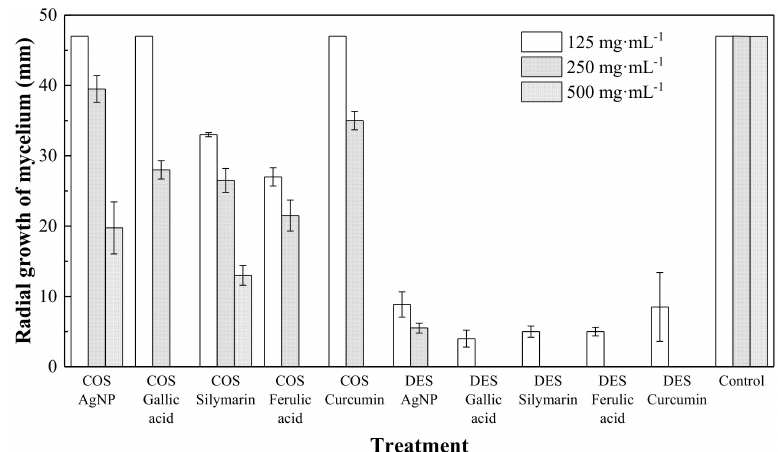
Figure 3. Radial growth values of P. cinnamomi in the presence of the composites, which consisted of different polyphenol inclusion compounds and silver nanoparticles at different concentrations, either in a chitosan hydroalcoholic solution (COS) or in a deep eutectic solvent (DES). A control (no treatment) and two treatments with AgNPs (in COS and DES) without the inclusion compounds are shown for comparison purposes. Error bars represent the standard deviation across three replicates.